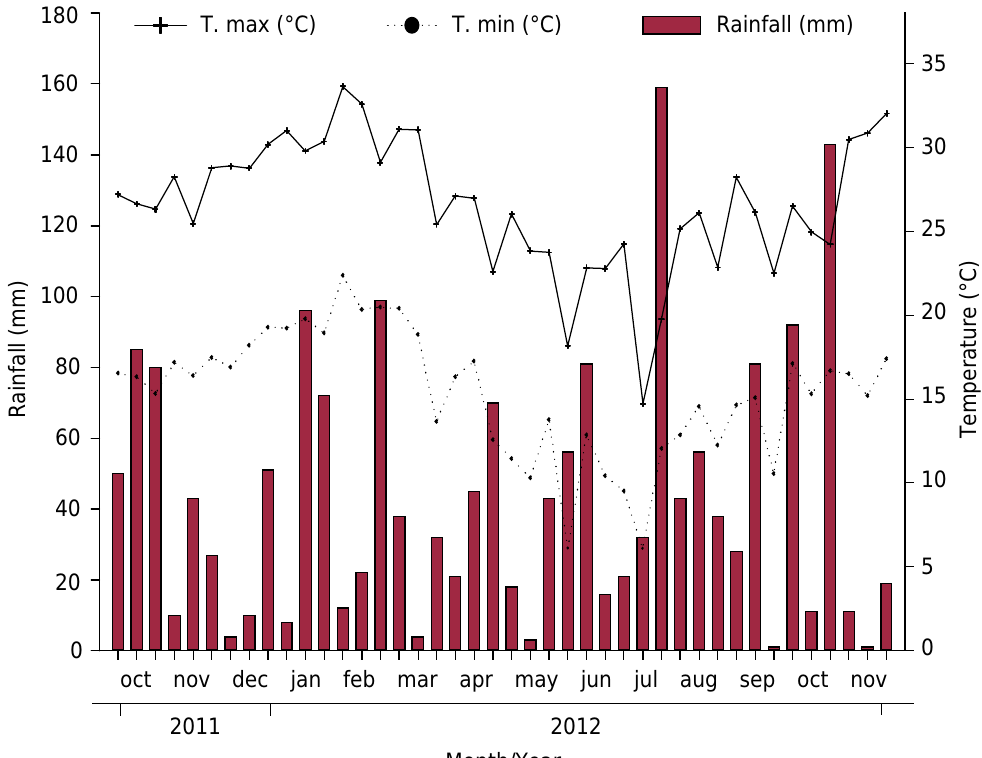
Figure 1. Means of maximum and minimum temperatures and sum of rainfalls at 10-day intervals during the